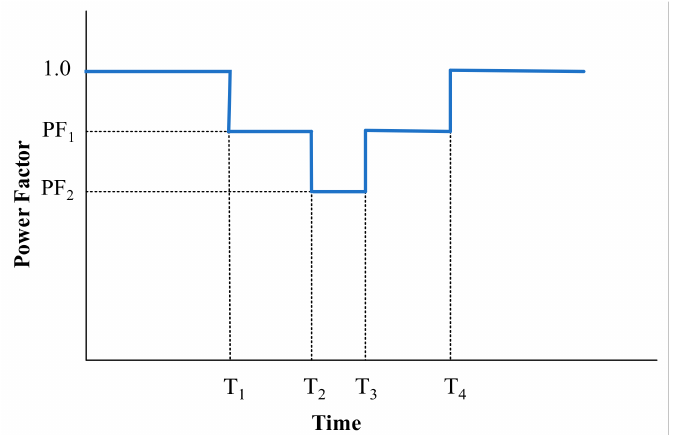
Figure 2. A generic power factor schedule for PV